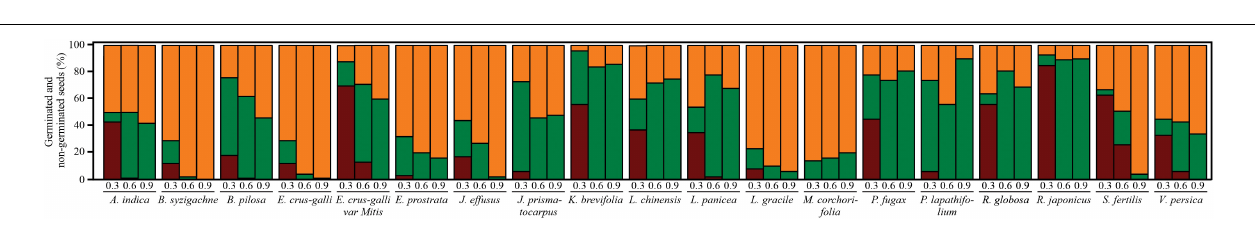
FIGURE 4 | Seeds germinated in PEG (dark red), after stress relief (green), and non-germinated (orange) in each osmotic potential (-MPa) and each plant species. Each bar denotes the mean of four true repetitions.